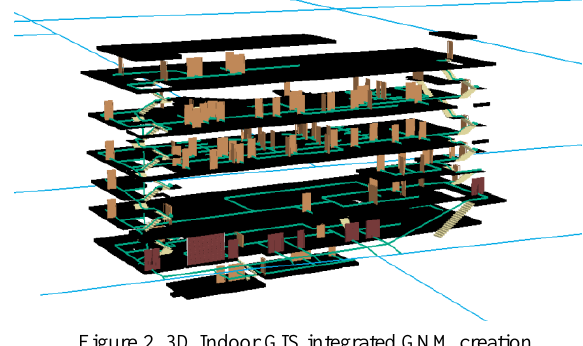
Figure 2. 3D Indoor GIS integrated GNM